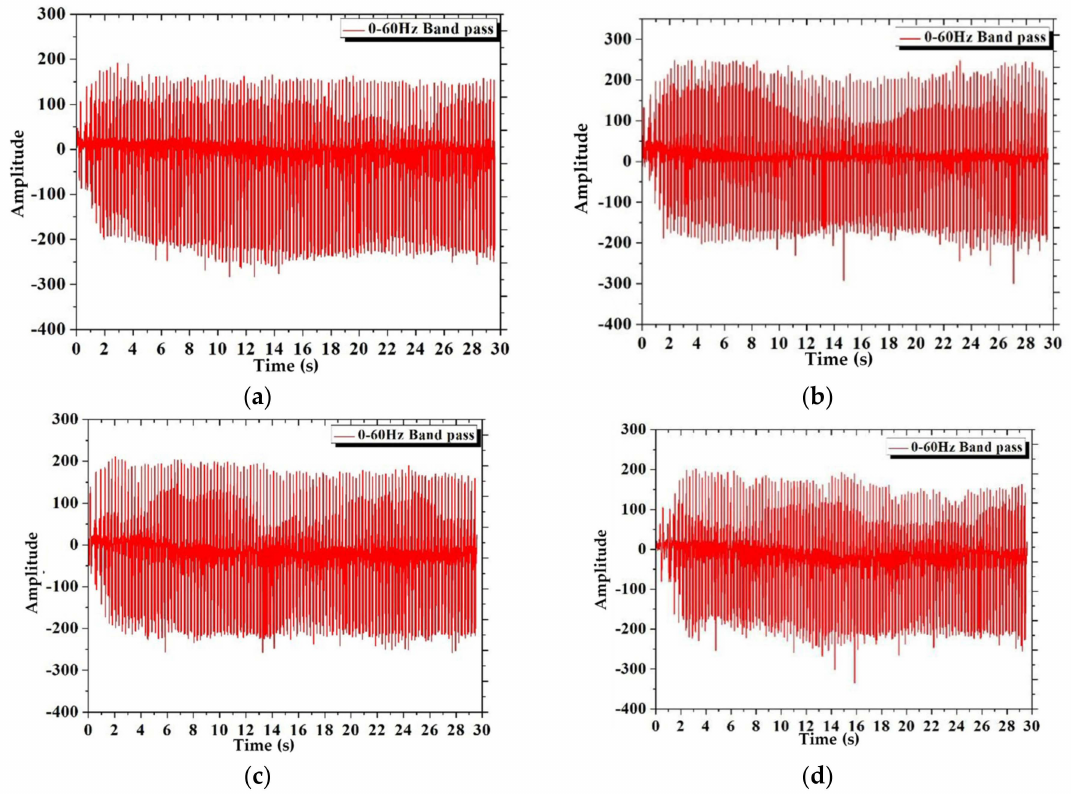
Figure 9. Vibration signals under four various terrain conditions after FFT filtering. ( a ) Straight working condition. ( b ) Horizontal bending condition. ( c ) Vertical bending condition. ( d ) Combined working condition of horizontal and vertical